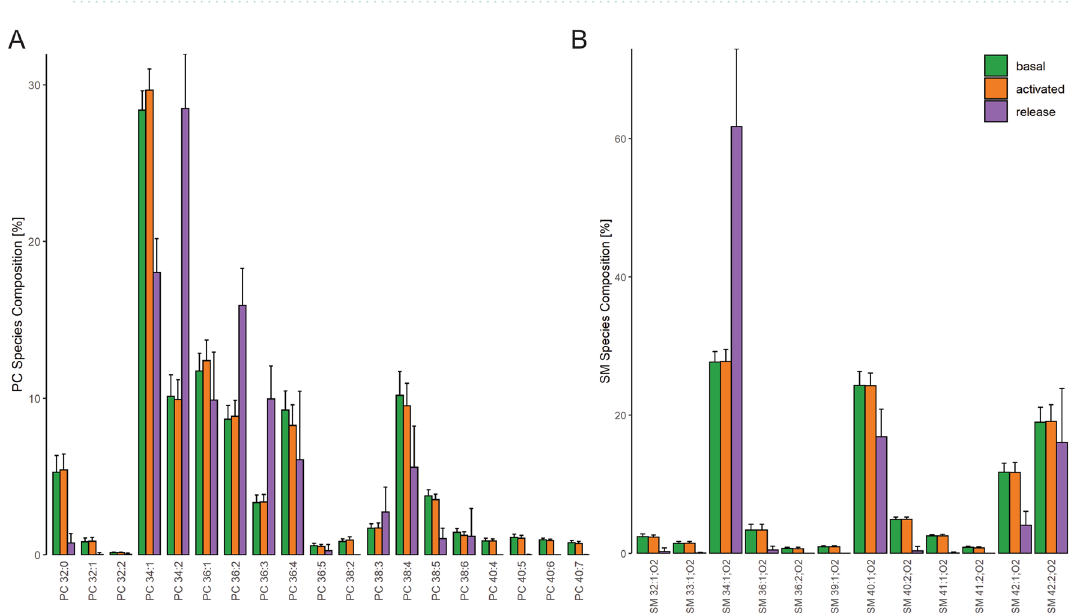
Figure 4. Lipid species profiles of PC and SM. Displayed are ( A ) PC and ( B ) SM lipid species profiles related to the sum of the respective lipid class of unstimulated (basal), activated platelets and lipid release upon thrombin stimulation. Mean and SD of 12 healthy human